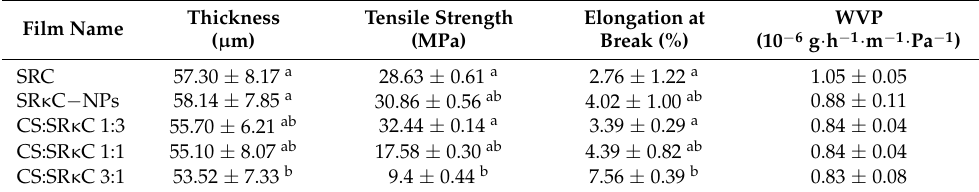
Table 2. Thickness, tensile strength (TS), elongation at break (EB), and water vapor permeability (WVP) of the bionanocomposite films.